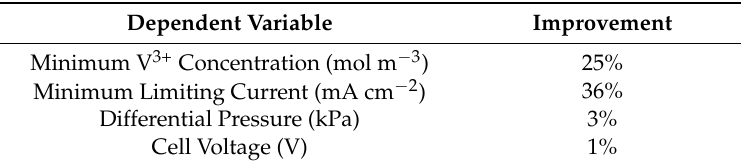
Table 2. Comparison between Cases 2 and 4 for key criteria. Values are relative improvement (%) over conventional geometry.